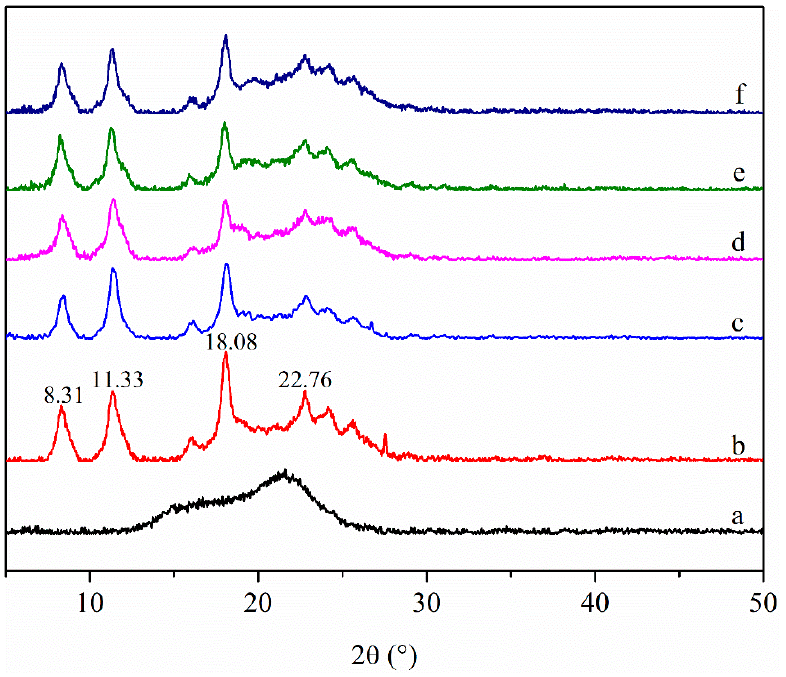
Figure 4. XRD patterns of LPP ( a ), CHS film ( b ), CHS-2.5LPP ( c ), CHS-5LPP ( d ), CHS-7.5LPP ( e ), and CHS-10LPP ( f ). and CHS-10LPP ( f